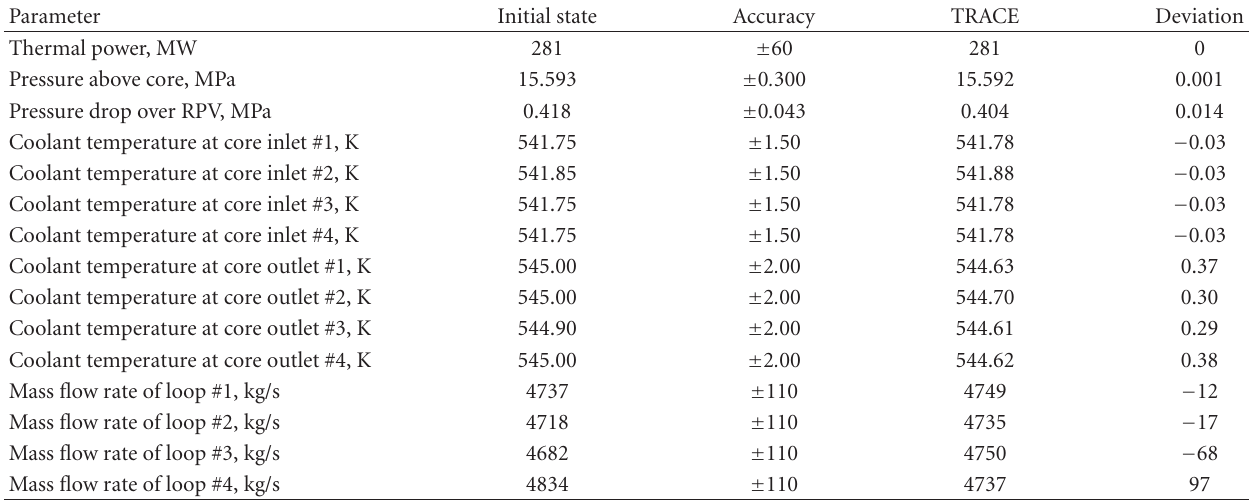
Table 3: Comparison of TRACE predictions with plant data for the initial state.